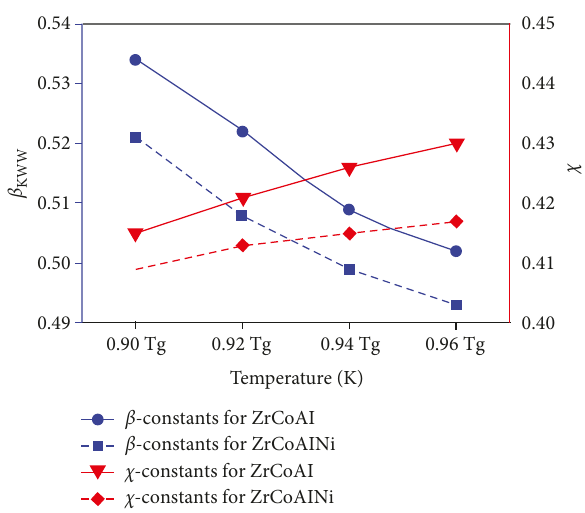
Figure 9: Variations of β